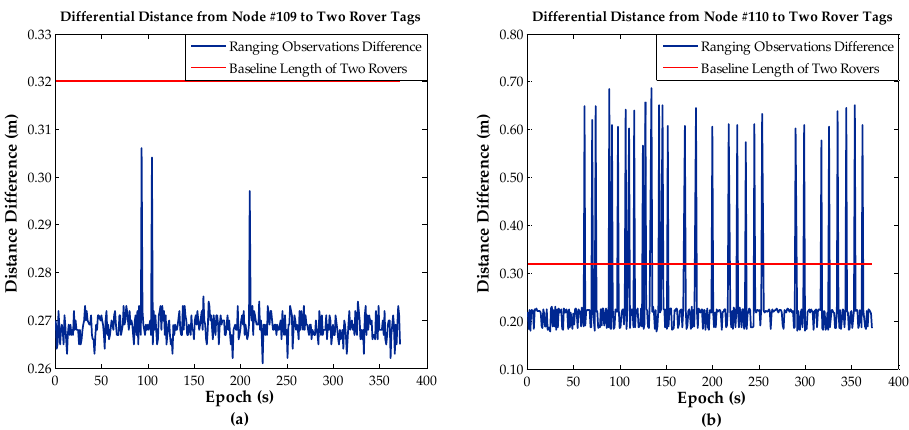
Figure 8. ( a ) The difference of ranging observations (from #109 to two rovers); ( b ) The difference of ranging observations (from #110 to two rovers).